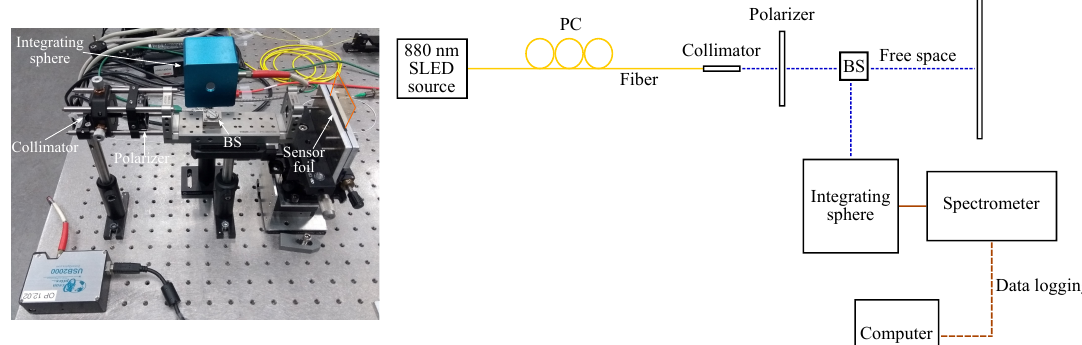
Figure 18. A picture and a schematic of the setup in reflection. PC = polarization controller; BS = beam splitter.